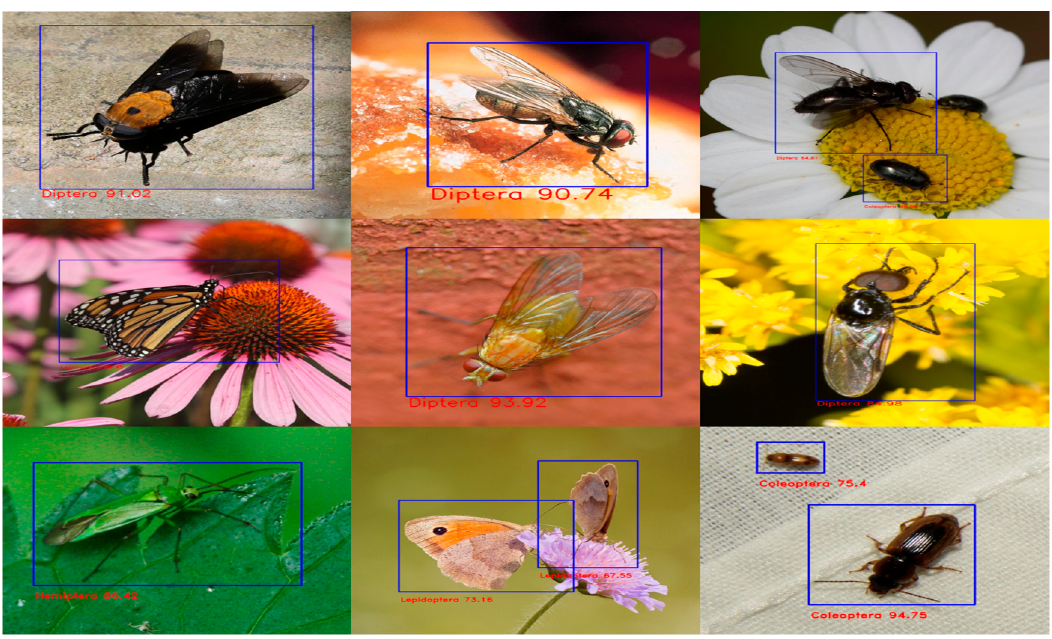
Figure 7. Detection results of YOLOv5x on different insect orders. Table 3. Performance comparison of all five models used in the experimental study using statistical